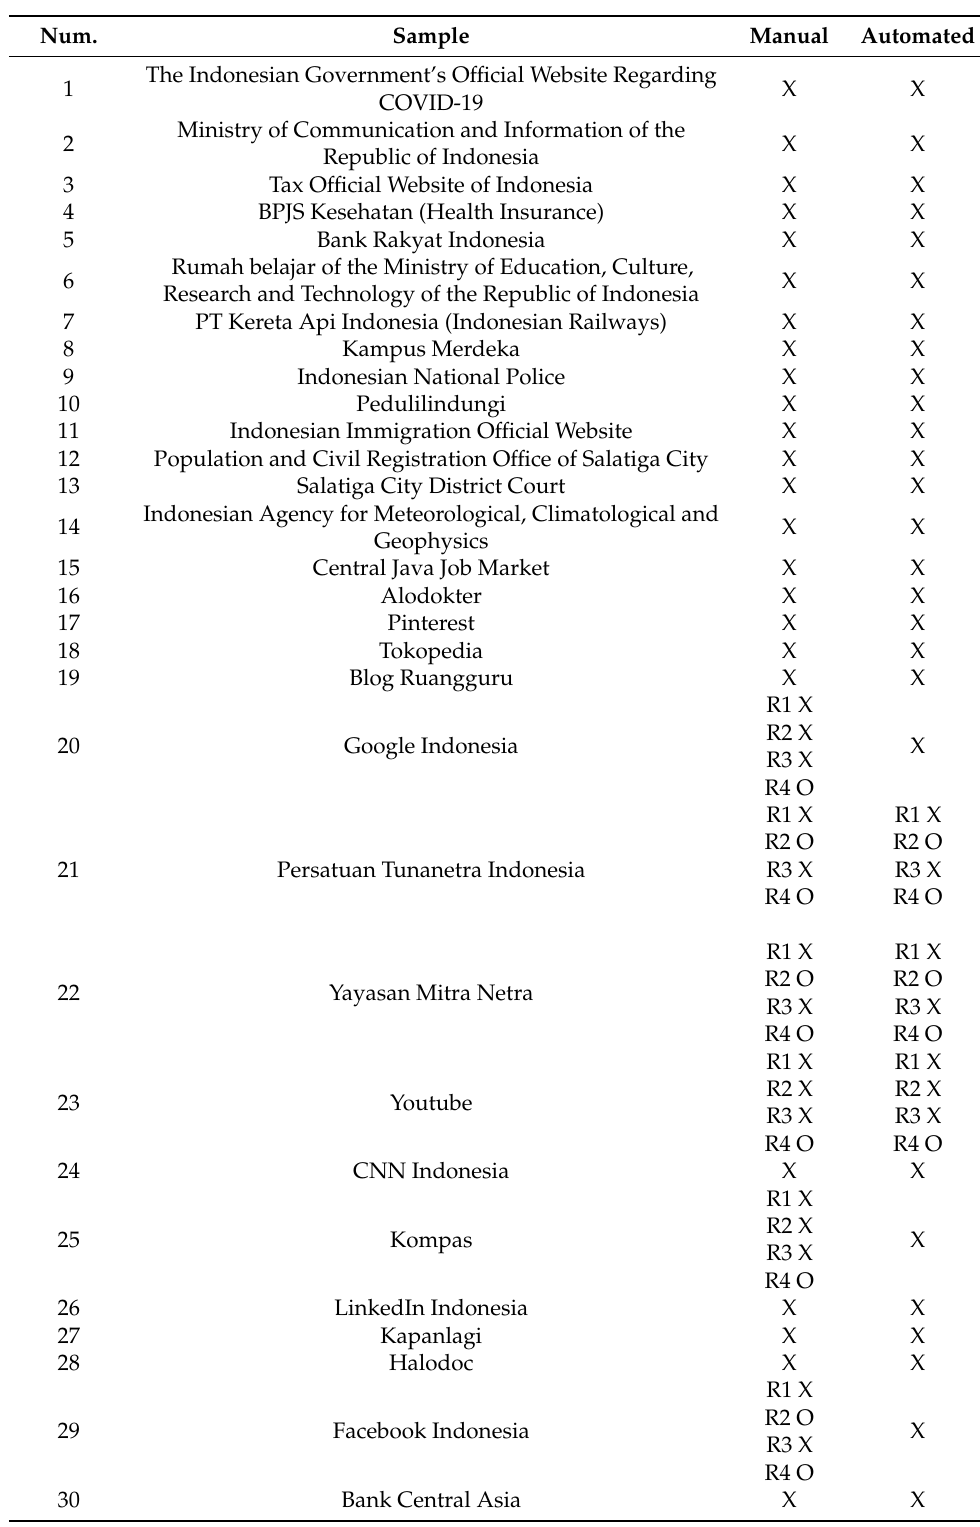
Table 4. Manual and automated test results.